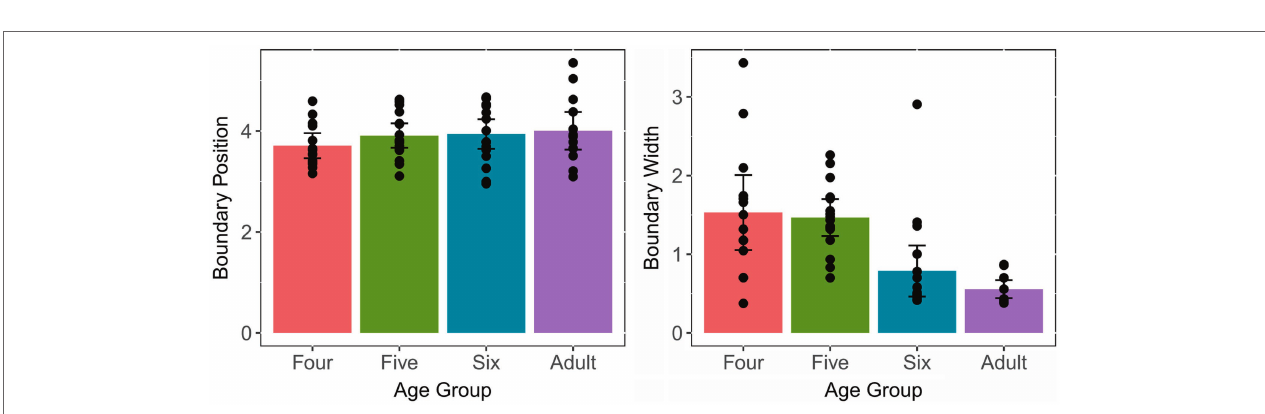
FIGURE 3 | The identification and discrimination curves across four age groups. The dotted line represents Tone 1 responses. The dashed line indicates Tone 2 responses. The solid line refers to discrimination curves.